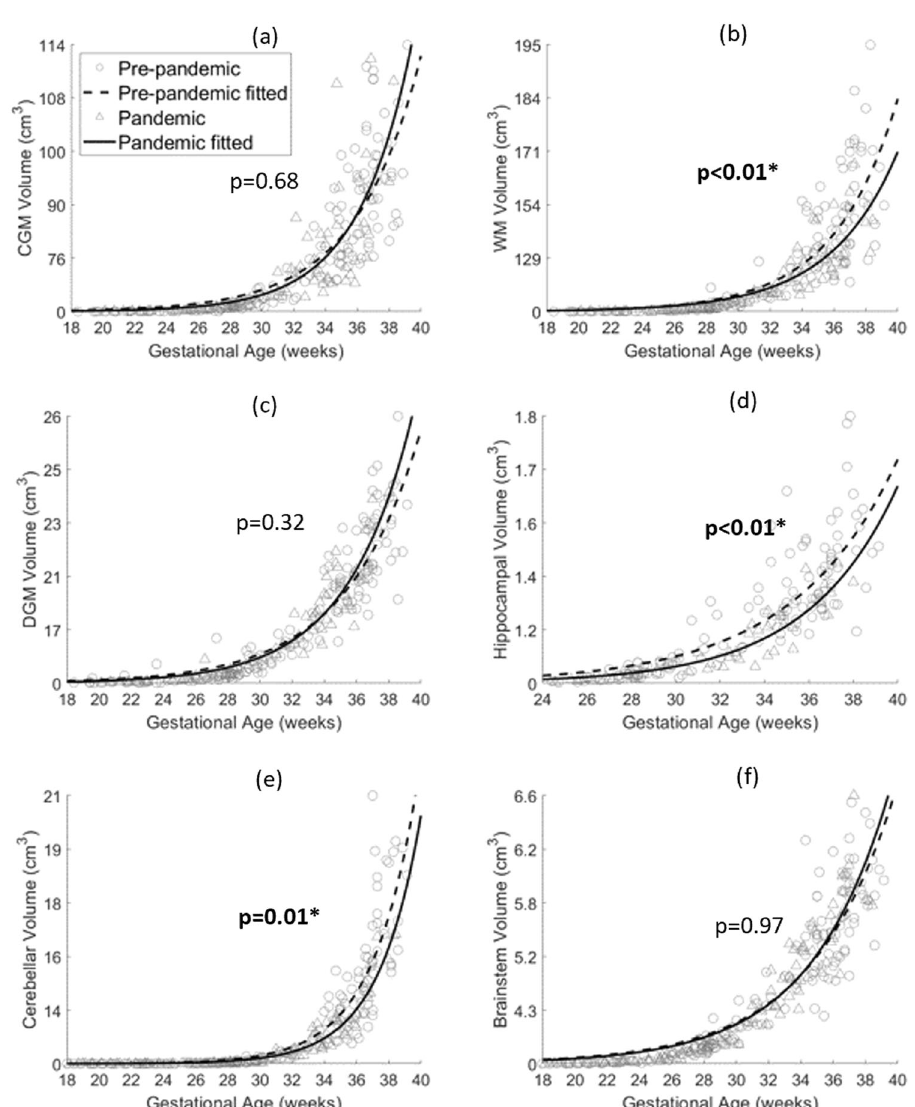
Fig. 1 Scatter plots with exponential fi ts of brain tissue volumes vs. gestational age. a Cortical gray matter (CGM); b White matter (WM); c Cerebellum; d Deep gray matter (DGM); e Brainstem; f Hippocampus. The p -values are the main effects of pandemic vs. pre-pandemic on brain tissue volumes while controlling for gestational age at MRI and fetal sex. Bold p : p < 0.05. *: q < 0.05. Sample size N =